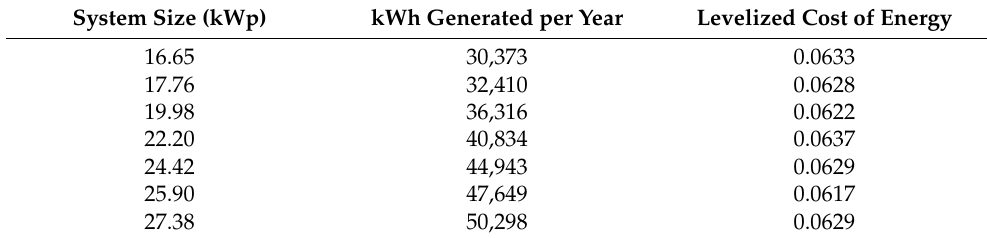
Table 9. Values of kWh generated per year for each off-grid system